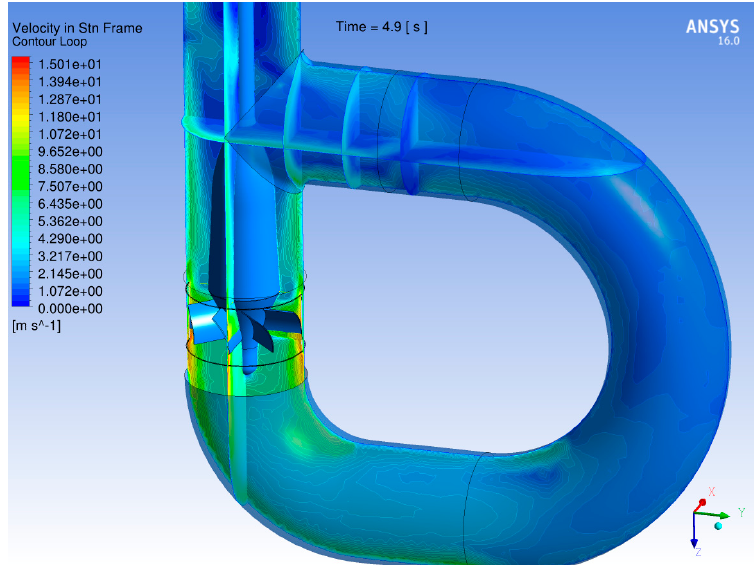
Figure 21. Velocity contours plotted on different plane inside the fluid domain.